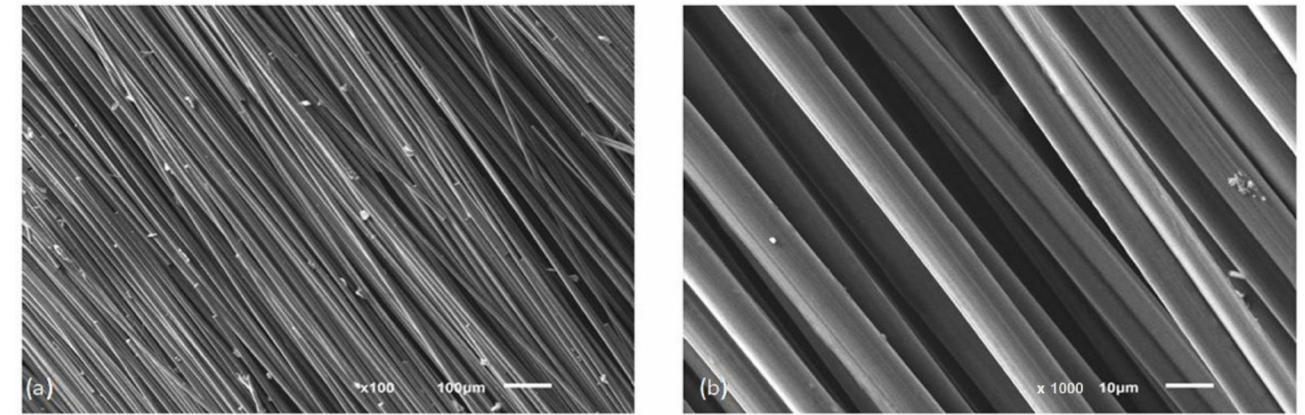
Figure 2. SEM images of long carbon fibers K1100 typically used for the preparation of carbon